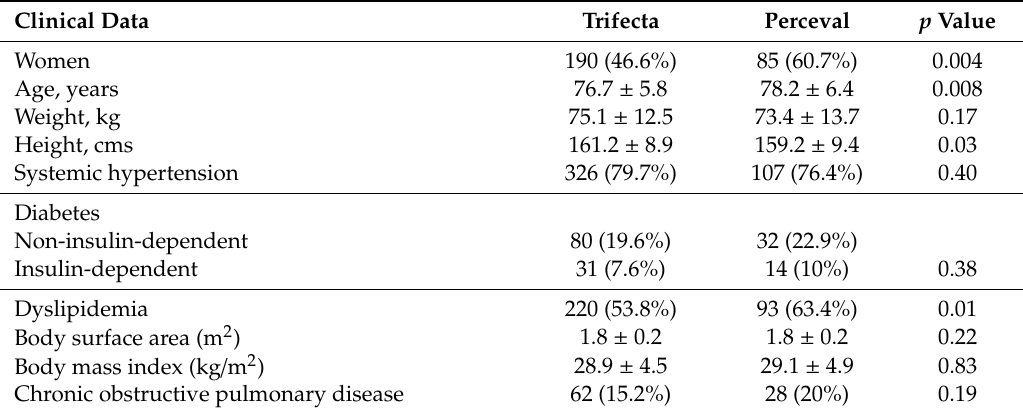
Table 1. Baseline